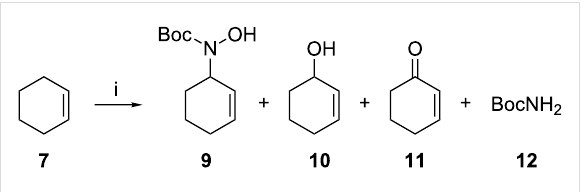
(Figure 1) catalyse the allylic amination of cyclohexene. Mech-